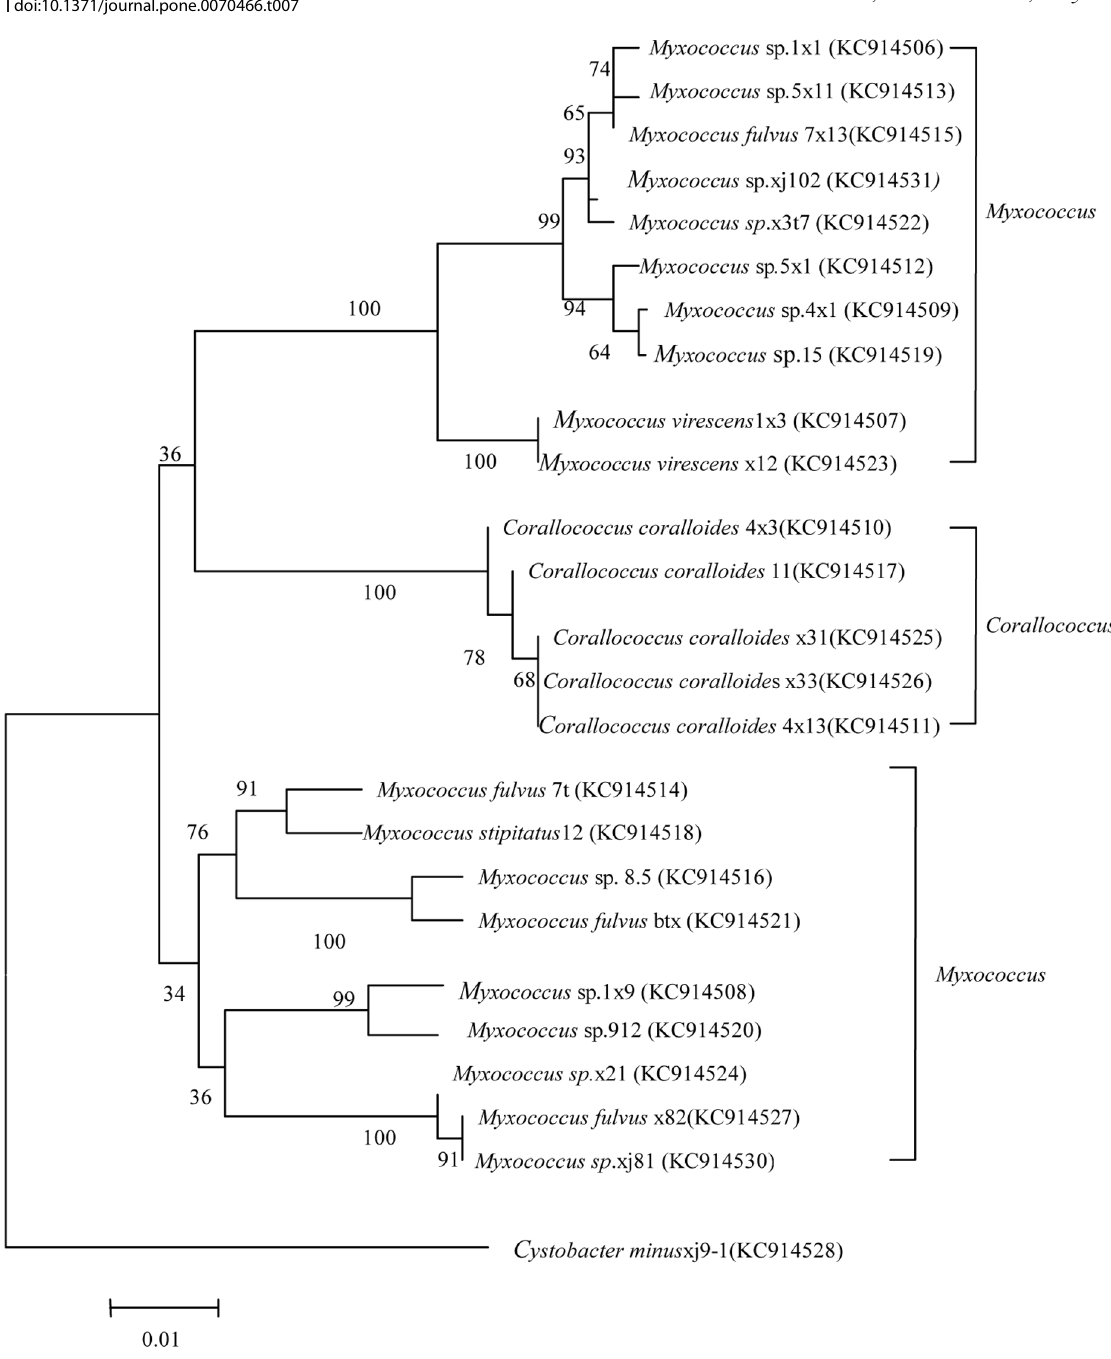
Figure 5. Phylogenetic relationships among 25 myxobacterial strains, inferred from lepA sequences. doi:10.1371/journal.pone.0070466.g005 PLOS ONE |